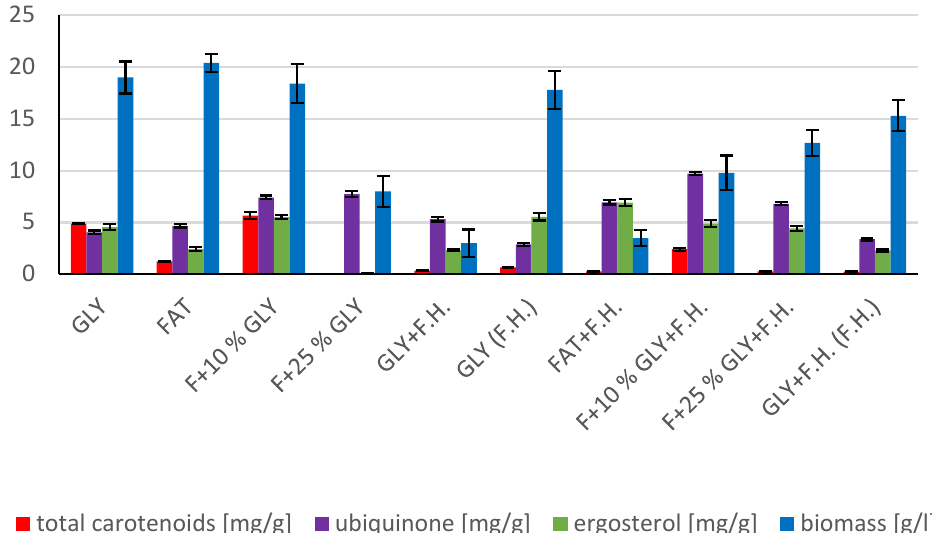
Figure 1. Metabolite production by biomass of yeast strain Rhodotosporidium toruloides in conditions of C/N ratio 25.